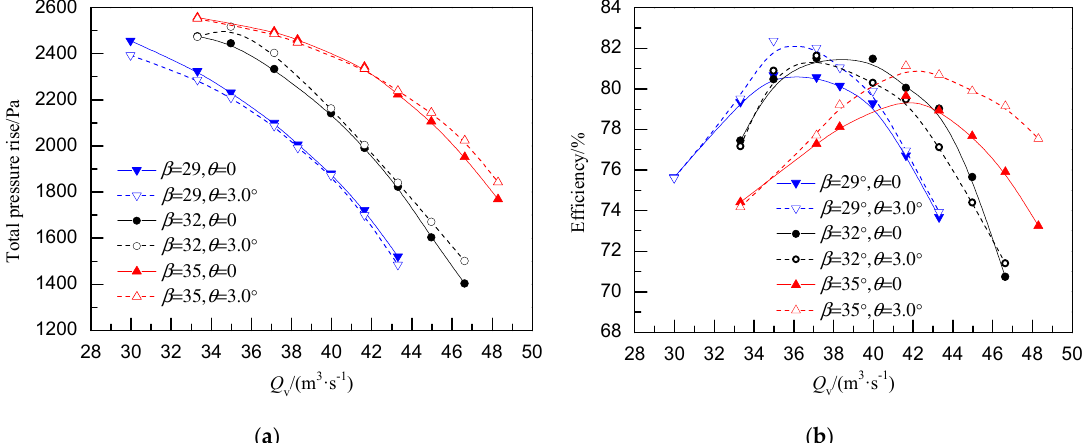
Figure 6. Performance curve of original fan at β = 29°, 32° and 35°. ( a ) total pressure rise; ( b ) efficiency.